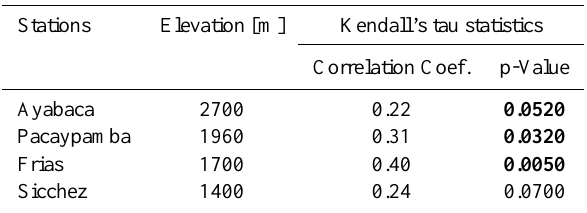
Table 2. Kendall’s tau statistics for the test of association between 2-yr MAM precipitation quantile anomalies and MAM SSTA 1.2 indices. Numbers in bold are considered statistically significant ( p ≤ 0 .